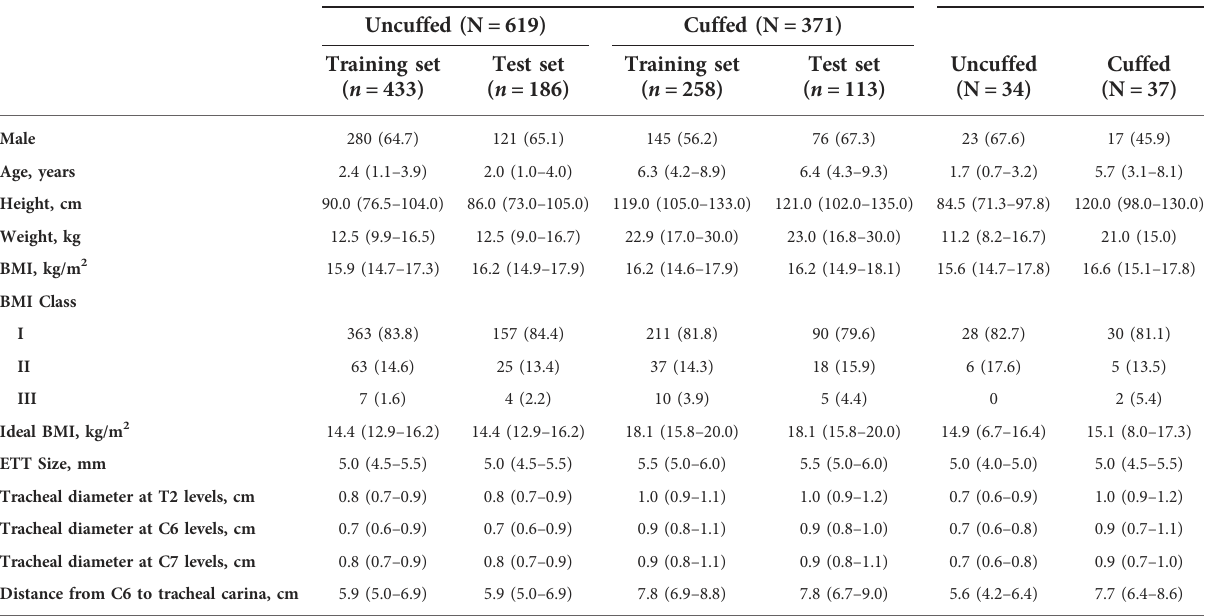
TABLE 1 Patient demographic data and variable